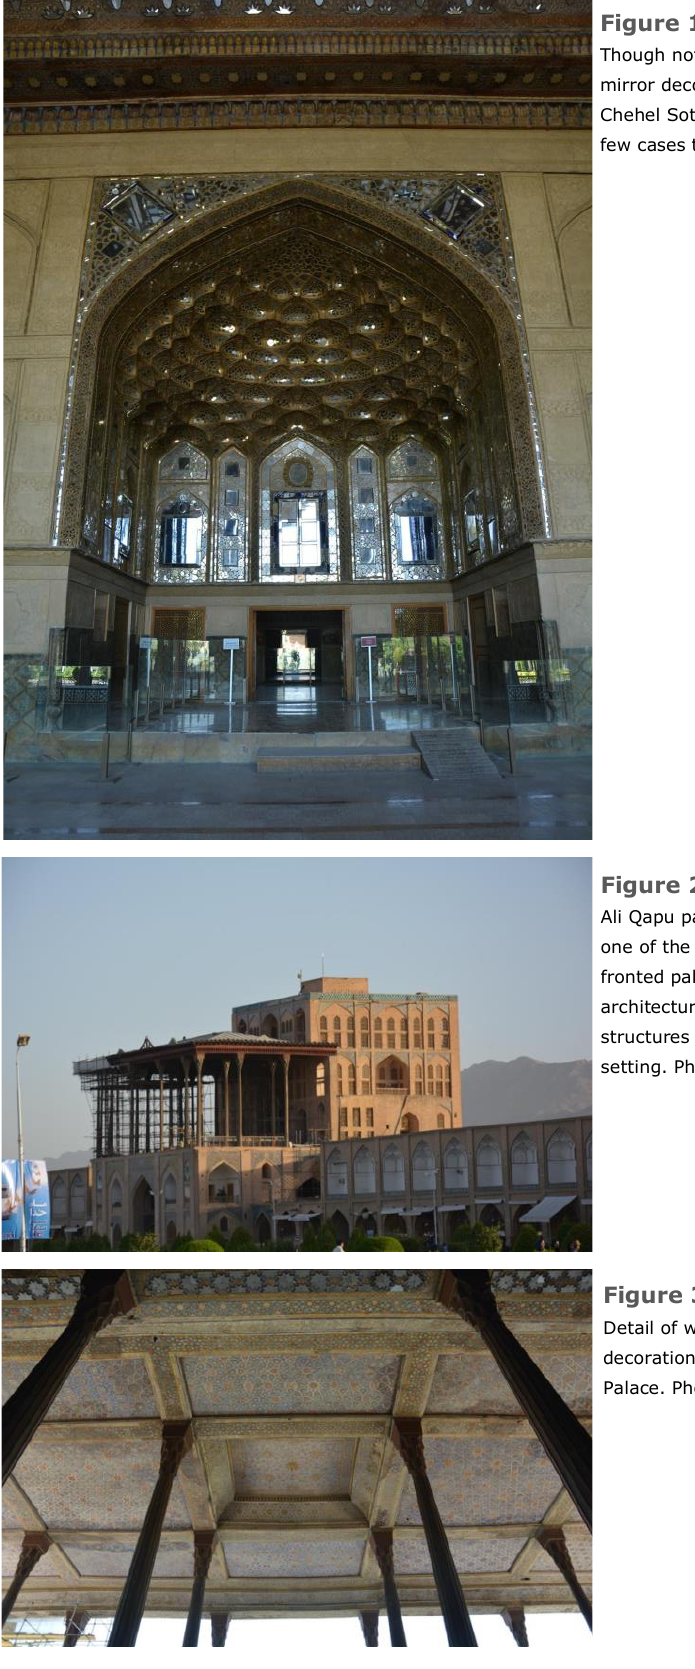
Detail of wooden columns and wooden decorations in the talar of Chehel Sotun Palace. Photo: Author.